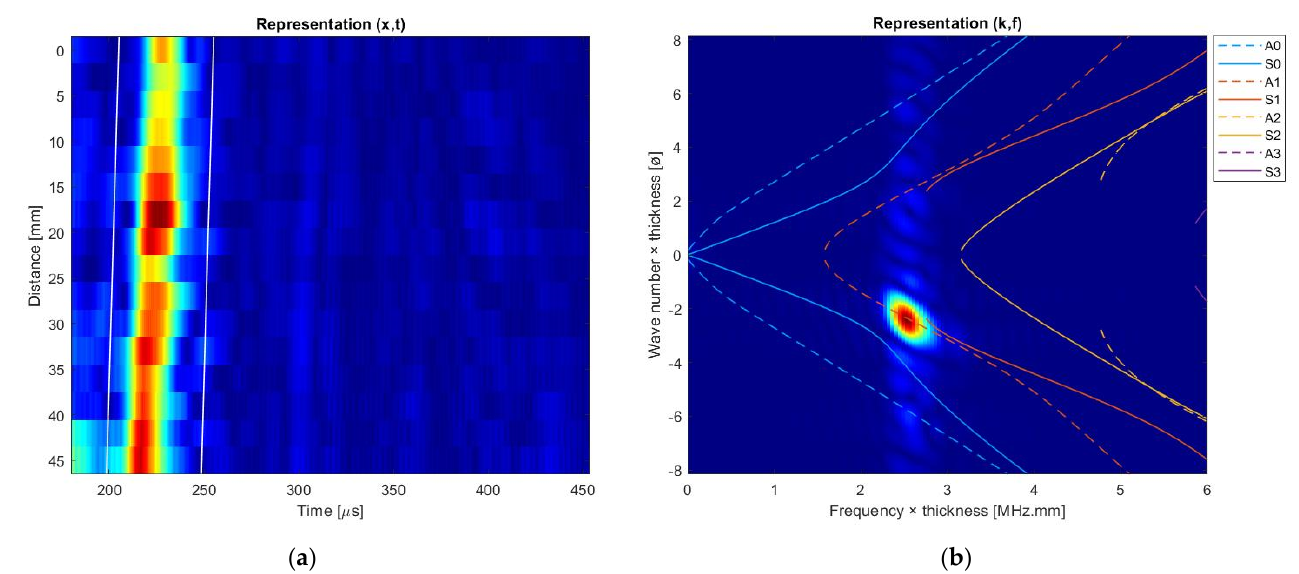
Figure 8. ( a ) Envelope of the experimental signals recorded by each element of the linear array—(x,t) representation; ( b ) 2D-FFT of the signals marked by the white lines—(k,f) representation. One can verify that the reflected mode corresponds to the initial propagative A1 mode: no conversion has occurred.